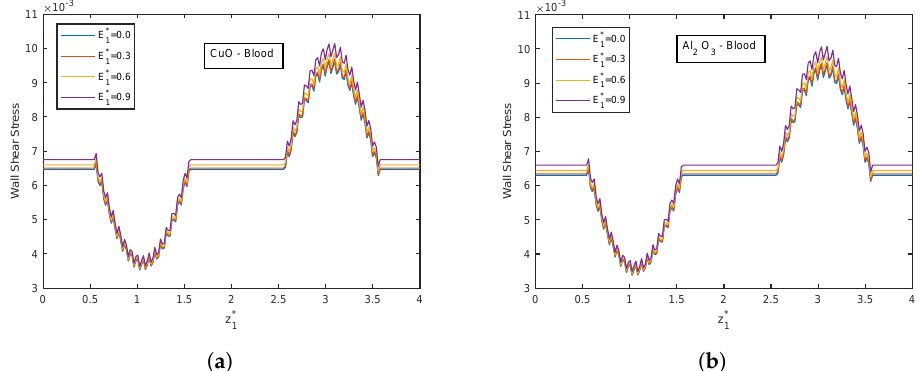
Figure 14. Wall shear stress profiles of electric field parameter E ∗ nanoparticles at t ∗ = 1.2. 1